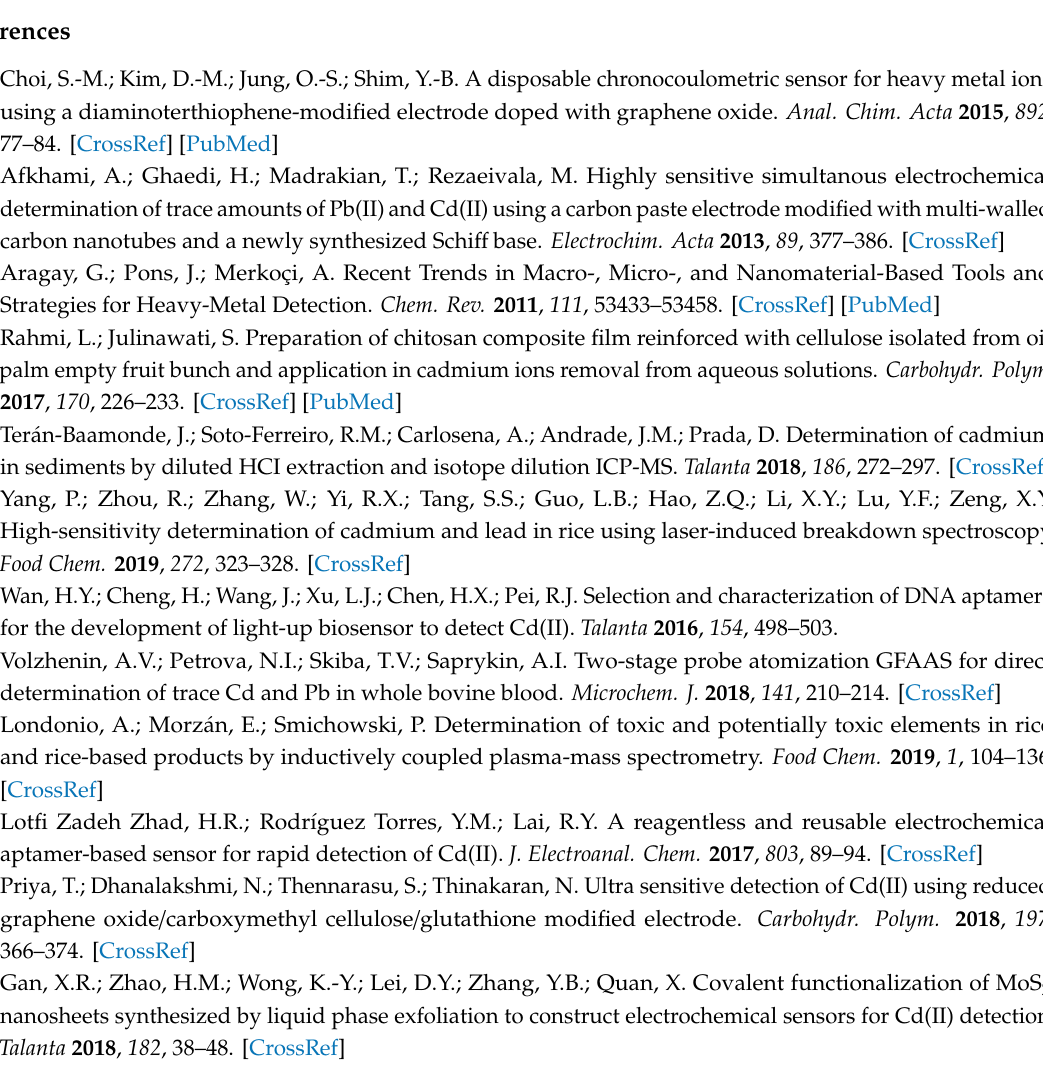
Supplementary Materials: The following are available online, Figure S1: (A) secondary structure of Cd(II) aptamer predicted using Mfold software. The part marked with red line has folded into a stem-loop structure. (B) solution., Table S1: Detection of Cd(II) in rice and drinking